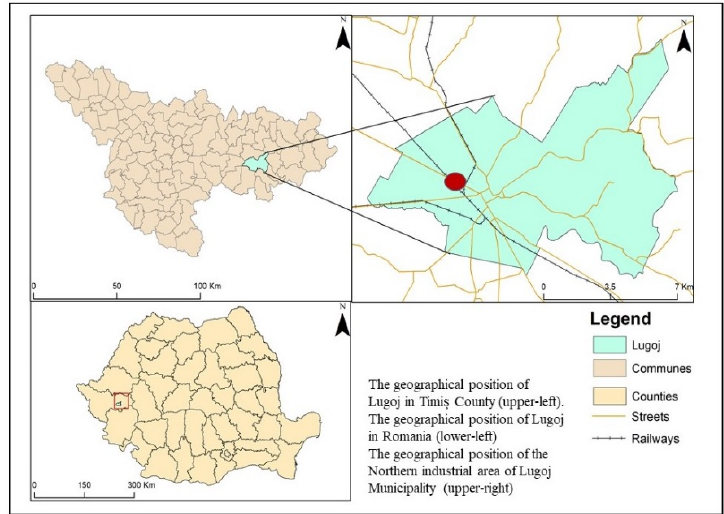
Figure 1. Study area: the geographical position of Lugoj municipality and its northern industrial area.